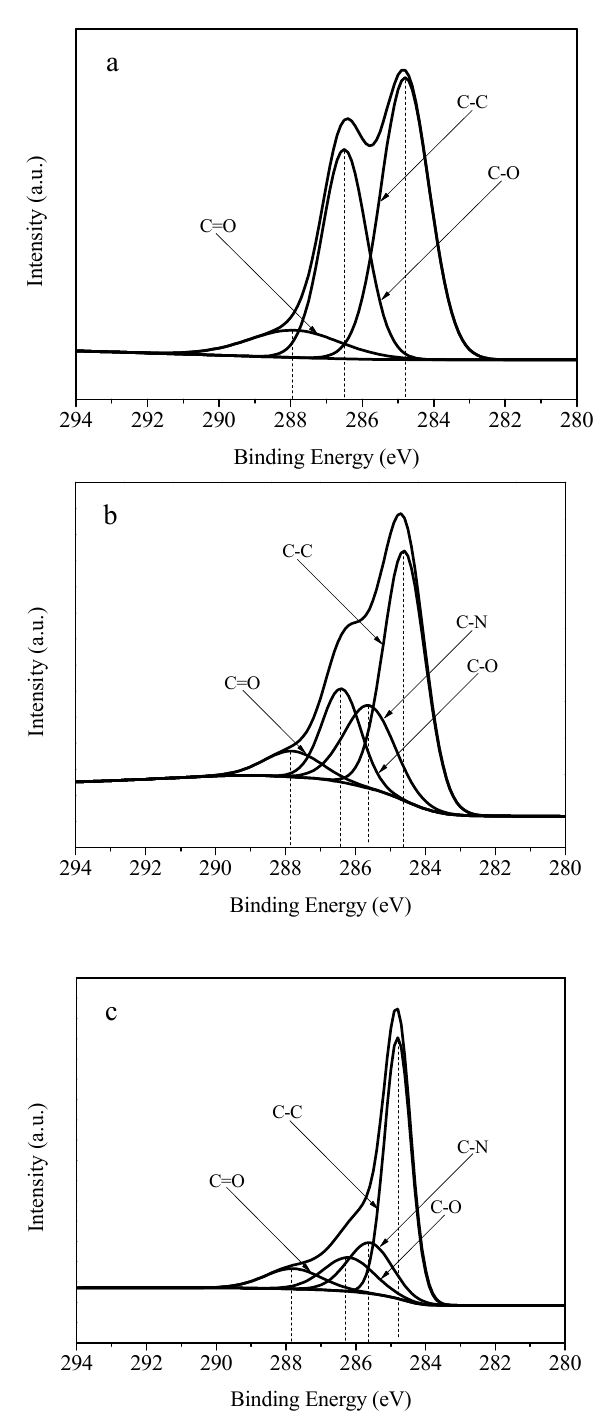
Figure 8. C 1s XPS spectra of ( a ) GO; ( b ) AgNWs/GO-2 and ( c ) AgNWs/GNs-2.